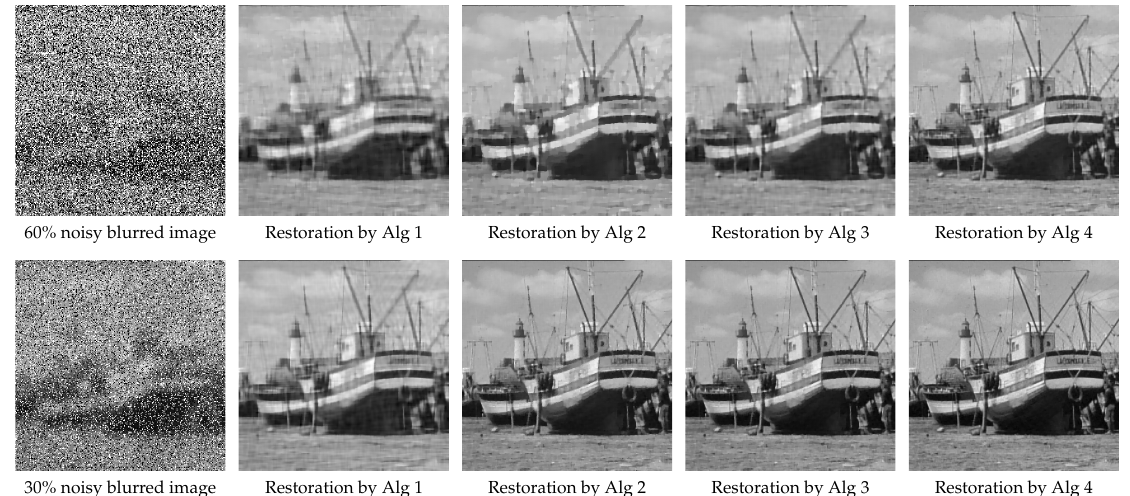
Figure 5. Image restoration for blurred Boat image with 60% or 30% salt-and-pepper